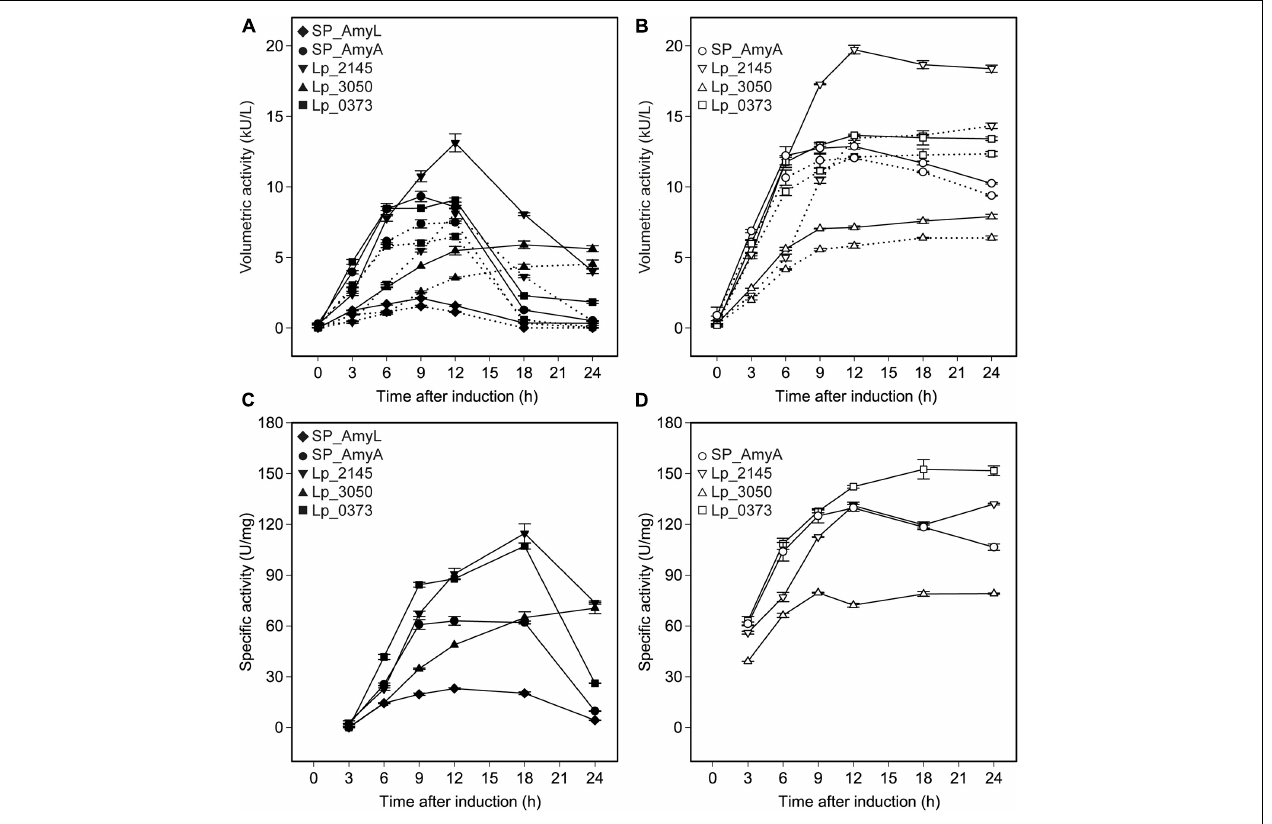
FIGURE 2 | Volumetric and specific α -amylase activities produced by recombinant L. plantarum WCFS1 harboring various expression plasmids of AmyL [ (A,C) , respectively] and AmyA [ (B,D) , respectively]. The solid lines and the dotted lines in panels (A,B) represent total volumetric activities and extracellular activities, respectively. Values given are the average values from at least two independent experiments and the error bars indicate the standard